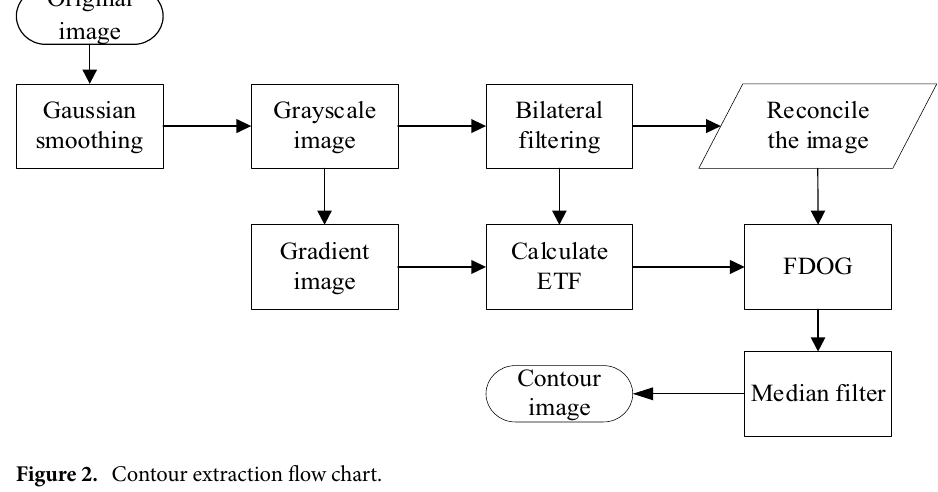
Figure 2. Contour extraction flow